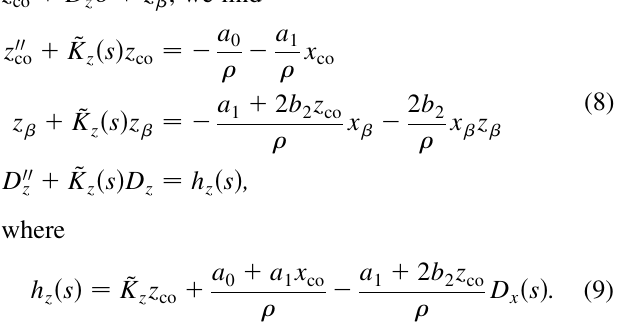
. Our numeri- c =(cid:7) is d c